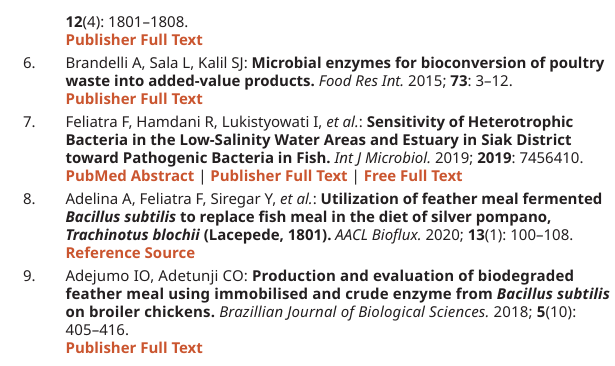
Data availability Figshare: Raw data of Cr2O3 and proximate composition of diets. https://doi.org/10.6084/m9.figshare.13109486.v1 35 . Figshare: Raw data of enzyme activity. https://doi.org/10.6084/ m9.figshare.13109495.v1 36 . Figshare: Raw data of feed and nutrient digestibility. https:// doi.org/10.6084/m9.figshare.13109501.v1 37 . Figshare: Intestinal histology. m9.figshare.13109498.v1 38